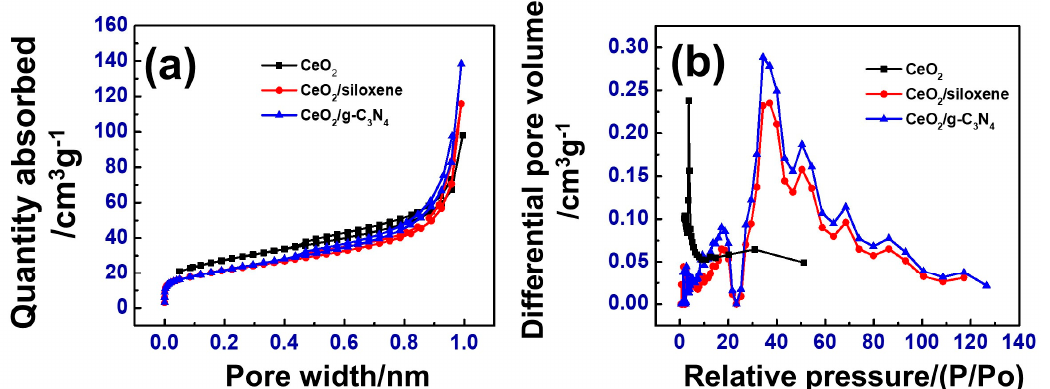
Figure 3. ( a ) Nitrogen adsorption–desorption isotherms; ( b ) Barrett–Joyner–Halenda (BJH) pore size distribution curves.